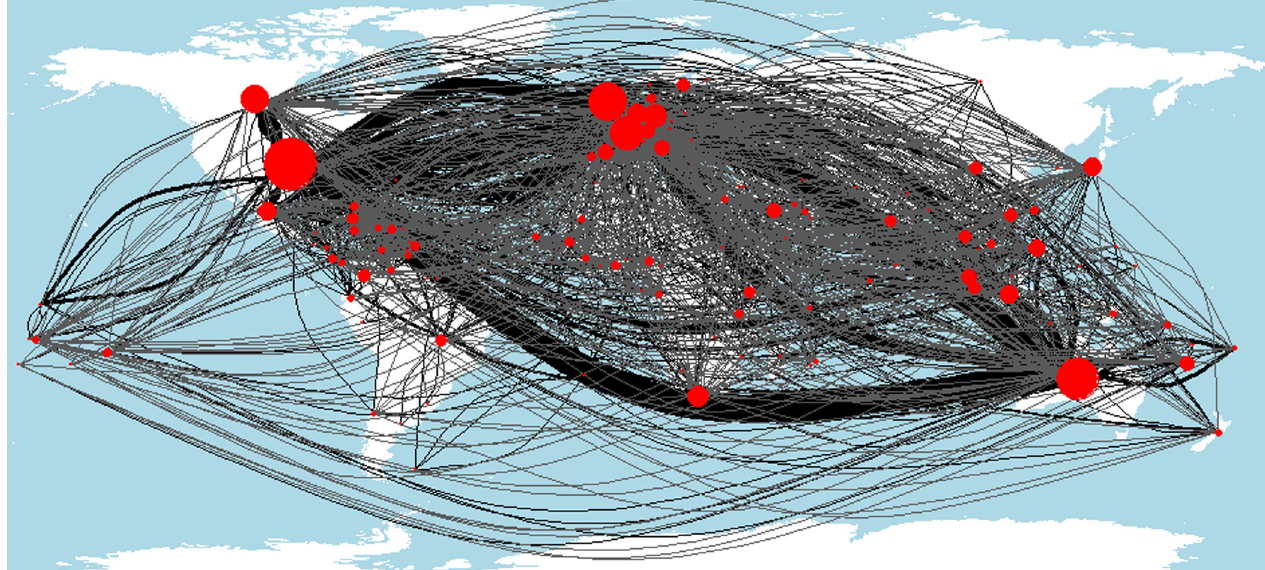
Fig 3. Spatial projection of an undirected network analysis of international authorship collaboration between countries. Red circular nodes indicate the number of international collaborations of individual countries. Node size is dependent on the total number of collaborations (i.e., all incoming and outgoing edge lines). The thickness of edge lines between countries represents the number of publications with authors from both countries. Node and edges sizes are scaled differently to enable better visualization. https://doi.org/10.1371/journal.pone.0228613.g003 on. The thickness of the arrow (i.e., edge connection) represents the number of publications. region.